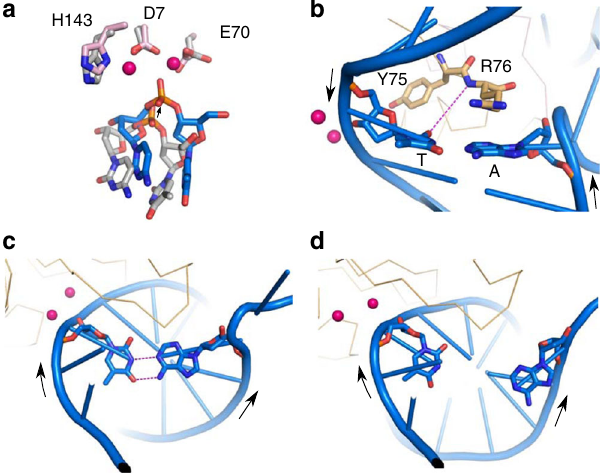
Fig. 2 Structural changes in MD simulations of the RuvC – DNA complex associated with the formation of catalytic-like geometry. a Close-up view of the active site of RuvC. Active-site residues and bases on both sides of the scissile phosphate are shown as blue and gray sticks for the MD simulations model and X-ray structure, respectively. Magnesium ions are shown as pink spheres. The black arrow indicates the motion direction of the scissile phosphate. b A new H-bond interaction between the protein backbone and scissile thymine formed in the simulations of the RuvC – DNA complex (purple). Helices B and preceding loops are shown in wire representation. Arrows show 5 ′ to 3 ′ polarity of DNA strands. c , d Pairing of the scissile T – A base pair. Arrows show 5 ′ to 3 ′ polarity of DNA strands. c A stable base pair in the crystal structure. d The broken base pair in MD simulations